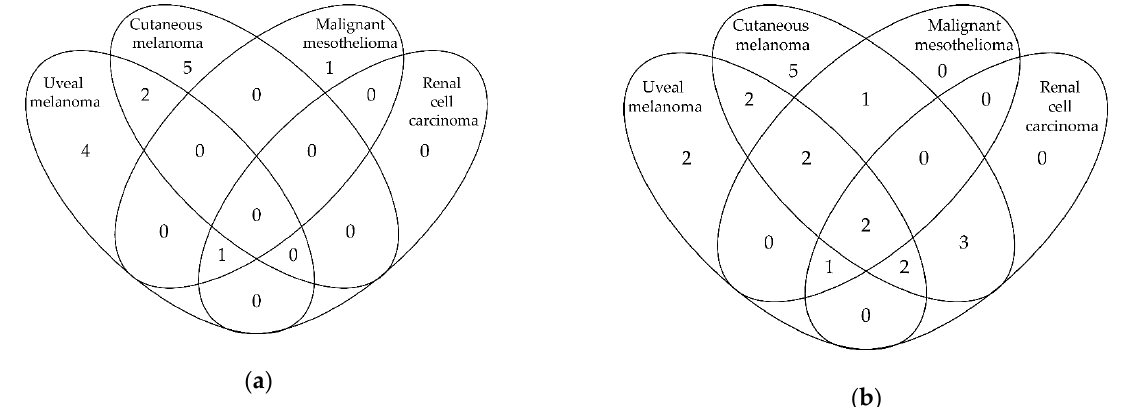
Figure 1. Venn diagrams of BAP1-tumor predisposition syndrome (BAP1-TPDS)-associated core malignancies found in BAP1-TPDS probands ( a ) and in the 21 BAP1-TPDS families ( b ). Eight probands were genetically analyzed as a result of the diagnosis of BINs and are, therefore, missing in Figure 1a.